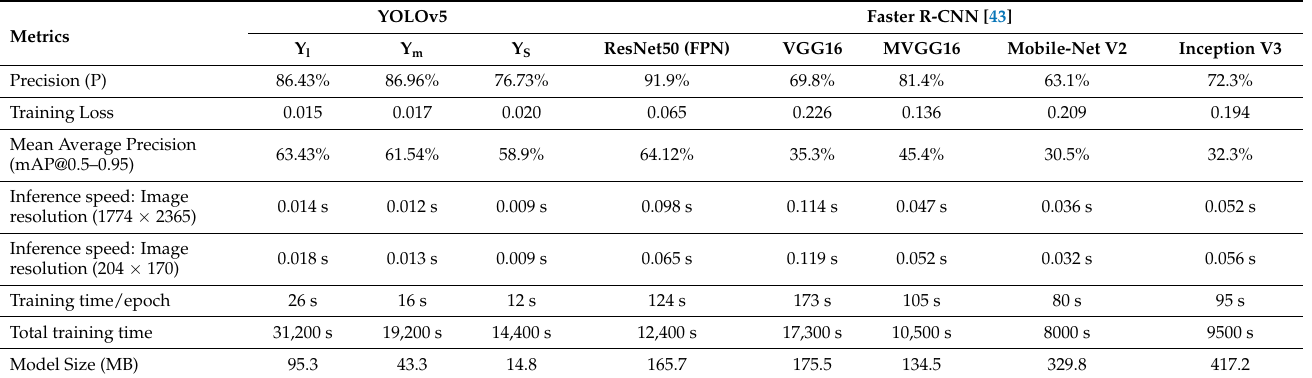
Figure 11. Training comparison of YOLOv5 Y s , Y m , and Y l models using different metrics: ( a ) precision value of Y s , Y m , and Y l in different epochs of training, ( b ) recall value of Y s , Y m , and Y l in different epochs of training, ( c ) mAP@0.5 of Y s , Y m , and Y l in different epochs of training, and ( d ) mAP@0.5–0.95 of Y s , Y m , and Y l in different epochs of training. Table 3. Comparison of YOLOv5 and Faster R-CNN performance.